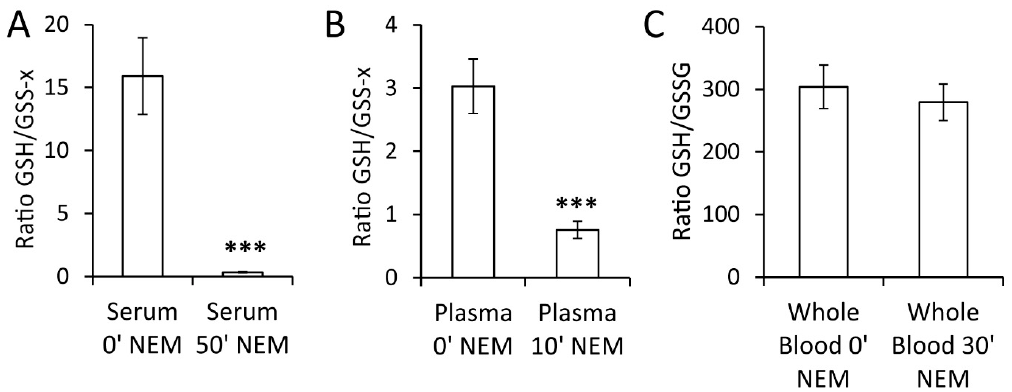
Figure 4. Delay in NEM addition resulted in lower GSH/GSSG ratios in serum and plasma samples.